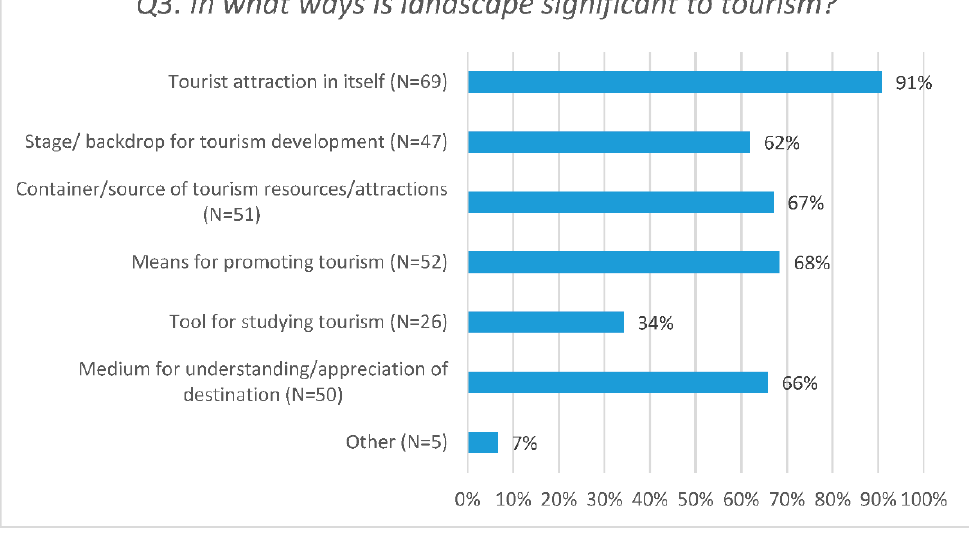
Figure 1. The ways that landscape is significant to tourism.